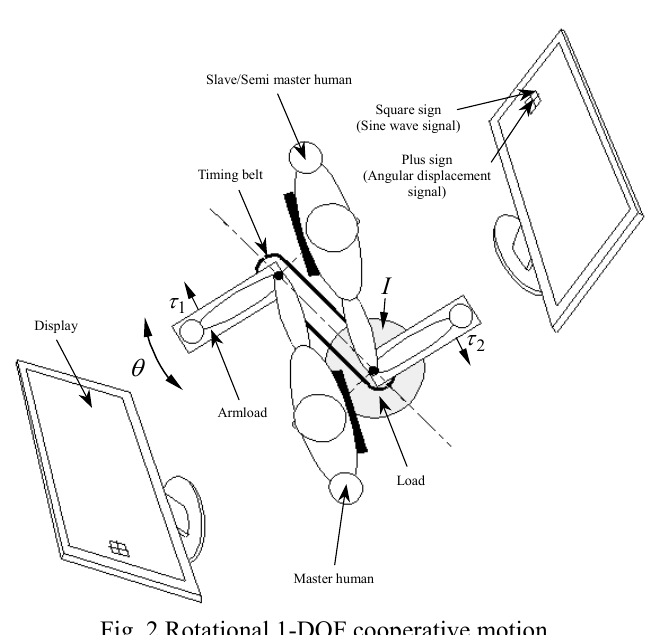
Fig. 2 Rotational 1-DOF cooperative